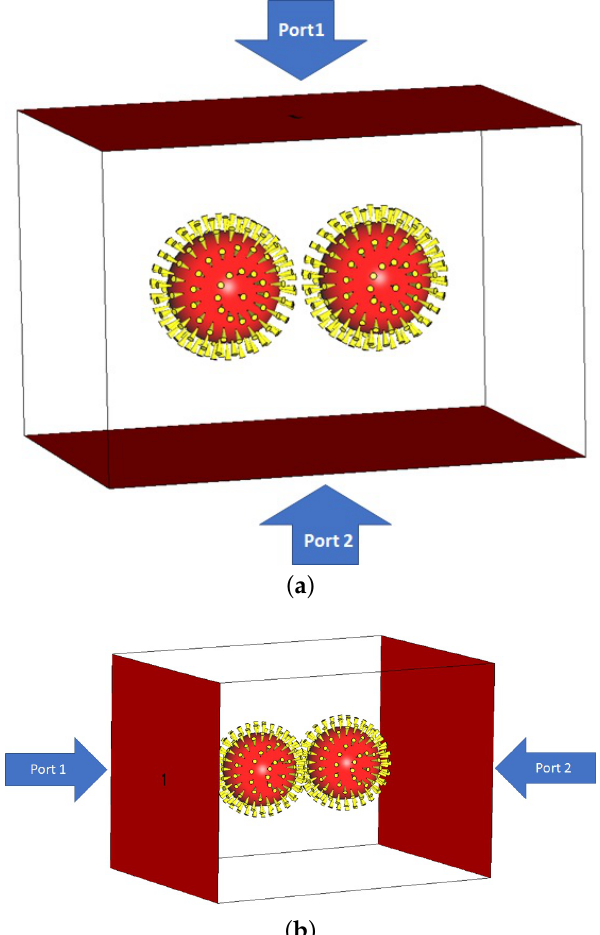
Figure 7. Stimulation schematic diagram for the demonstration of the COVID-19 model density implemented in CST with input and output ports for two states of optical excitation from ( a ) the top and ( b ) the side. The geometric size of COVID-19 particles’ structures is defined by r = 70 nm, h = 20 nm, D = 8 nm, and N =